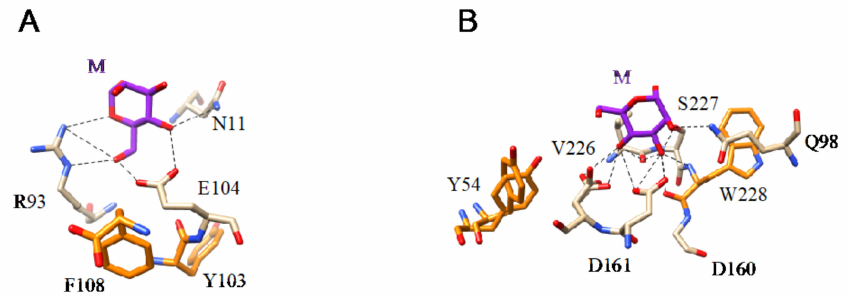
Figure 13. ( A ). Network of hydrogen bonds (black dashed lines) anchoring Man (M) to the amino acid residues N11, R93, and E104, forming the CBS of ginkbilobin from Ginkgo biloba (PDB code 4XRE). Aromatic residue Y103 and F108 participating in weak stacking interactions with the pyranose ring of Man are colored orange. ( B ). Network of hydrogen bonds (black dashed lines) anchoring Man (M) to the amino acid residues Q98, D160, D161, V226, and S227, forming the CBS of flocculin Flo5 from Saccharomyces cerevisiae (PDB code 2XJP). Aromatic residues Y54 and W228 involved in stacking interactions with the pyranose ring of Man are colored orange.